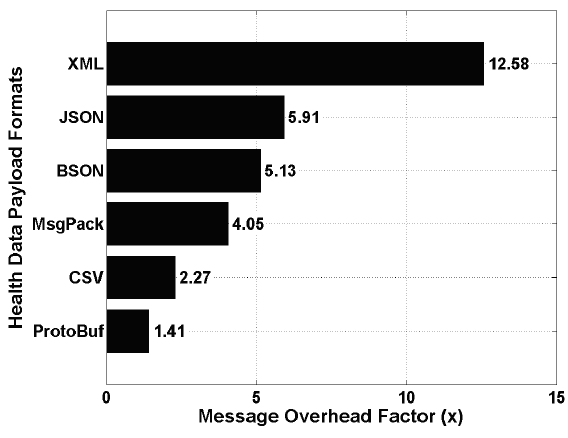
Figure 8. Performance of the data serialization formats—message overhead